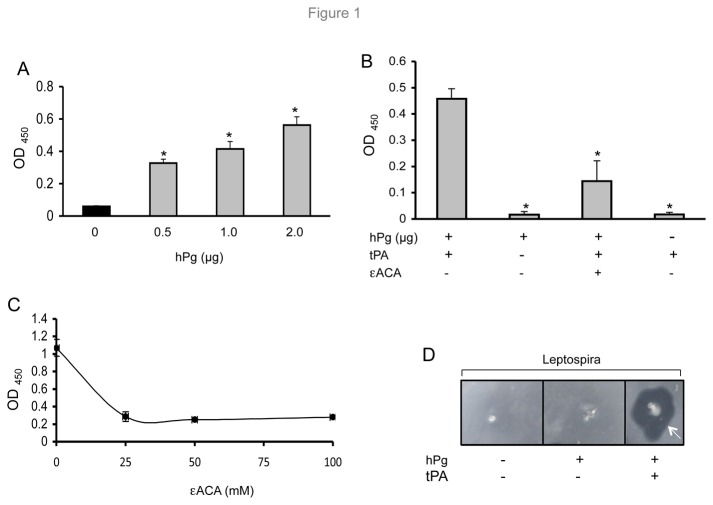
Plasminogen (Pg) binds L. interrogans enolase and activates plasmin.
The error bars indicate the standard deviations from three independent experiments performed in triplicate. * P
 < 0.05. (A) Pg binds to L. interrogans in a concentration-dependent manner. Microtiter plates were coated with fixed cells and incubated with various concentrations of human plasminogen (hPg). (B) L. interrogans converts Pg into plasmin in the presence of tissue plasminogen (tPA). Well-bound L. interrogans cells were incubated with hPg (1µg) and a chromogenic substrate (D-valyl-L-lysyl-p-nitroaniline hydrochloride) in the presence or absence of tPA and a known Pg inhibitor, a lysine analogue, ε-ACA. (C) A Pg inhibitor blocks L. interrogans-hPg interaction. Microtiter plates were coated with fixed L. interrogans and increasing concentrations (0 to 100 mM) of ε-ACA were incubated with a fixed amount (1µg) of hPg. (D) Fibrinolytic activity of Pg-bound L. interrogans. Panels represent L. interrogans cells in the presence or absence of hPg and tPA. Arrow denotes fibrinolytic activity of spirochetes only in the presence of both hPg and tPA.